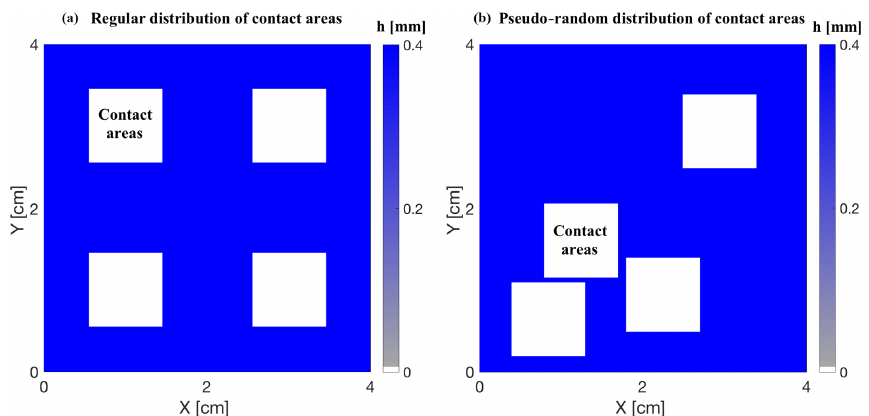
Figure 2. Fracture apertures with regular (a) and pseudo-random (b) distributions of contact areas. Blue zones represent open regions of the fracture with 0.4mm aperture. Each contact area size is 0.9 × 0.9cm, and the contact area density is 20%.